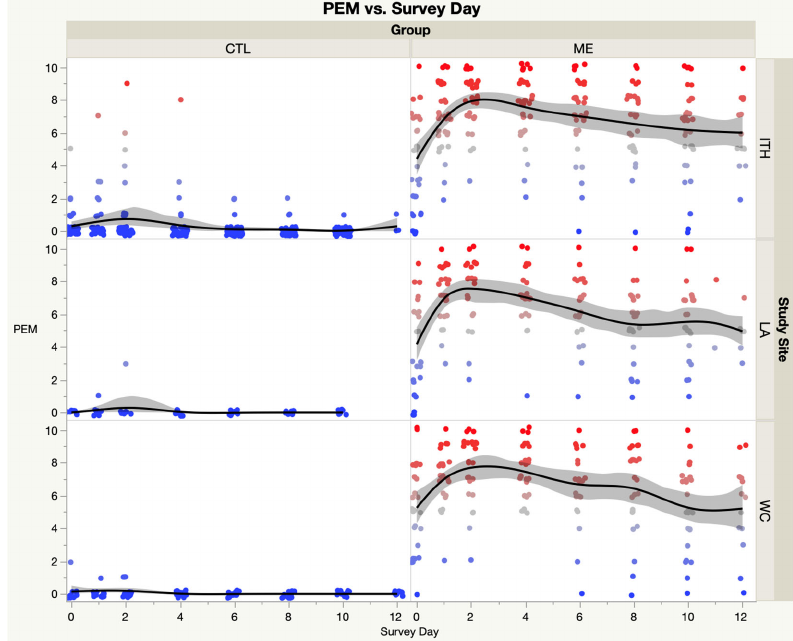
Figure 5. PEM domain score of SSS instrument by study site—ME/CFS vs. CTL. Fatigue domains score of SSS instrument—ME/CFS vs. CTL. Each dot represents the PEM score for a single subject; Blue dots are low scores, red dots are high scores; Black lines represent the spline curves for group averages; Grey shaded areas are the 95% confidence intervals.